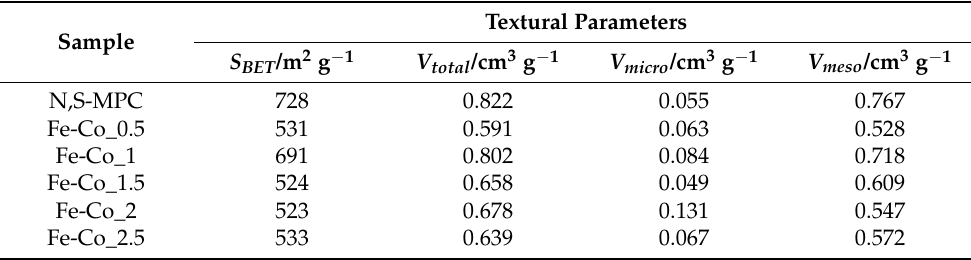
Table 1. Textural parameters of the carbon support for the bare N,S-MPC carrier, and spinel/N,S- MPC